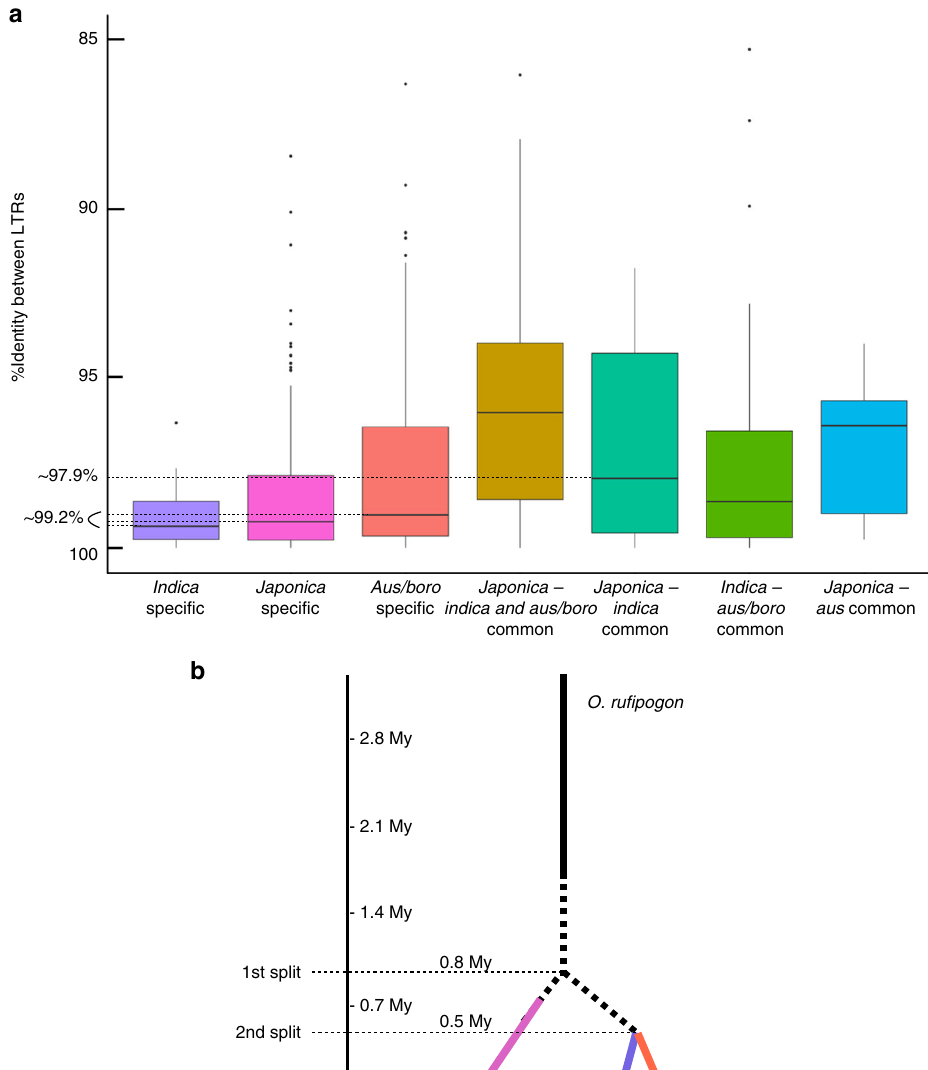
Fig. 6 Origin of rice domestication. a The box plots represent the distribution of percent identity between LTRs of retrotransposons for insertions that are Indica -speci fi c ( N = 91), Japonica- speci fi c ( N = 266), Aus/Boro -speci fi c ( N = 216), common to the three groups ( N = 138), common to Indica/Japonica ( N = 32), common to Indica / Aus ( N = 30), and common to Japonica / Aus ( N = 12), respectively. The three horizontal dashed lines correspond to the mode of distribution of Indica -, Japonica -, and Aus-speci fi c insertions. b Representation of the history of the three domestications of Asian